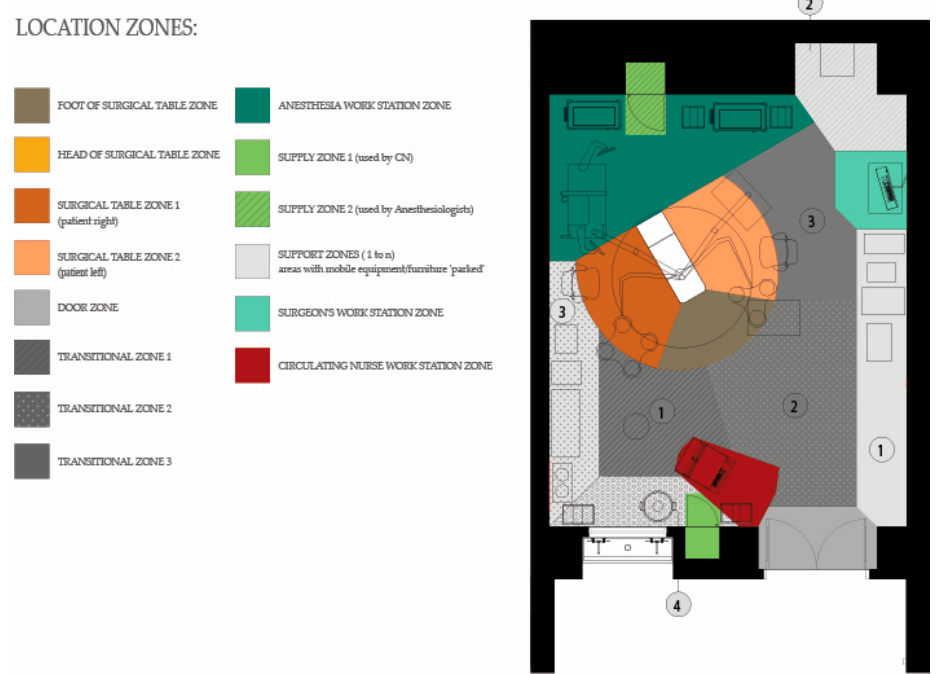
Figure 2. Location and type of zones in the ORs.